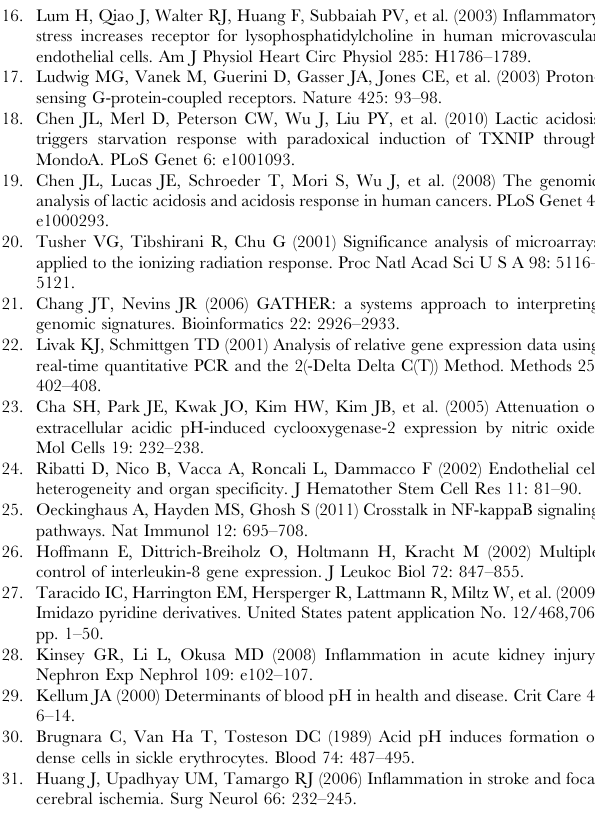
Table S3 SAM analysis of genes that were induced by GPR4 overexpression in HUVECs. (XLSX) Table S4 SAM analysis of genes that were repressed by GPR4 overexpression in HUVECs. (XLSX) Table S5 Table of Gene Ontology enrichment generated by GATHER using the GPR4 overexpression-induced genes from Table S3. (XLSX) Table S6 Table of Gene Ontology enrichment generated by GATHER using the GPR4 overexpression-repressed genes from Table S4. (XLSX) Table S7 Fold changes of gene expression by real-time RT-PCR in HUVEC/Vector and HUVEC/GPR4 cells upon varying pH treatment. (DOC) Video S1 Adhesion of U937 monocytes to HUVEC/ Vector cells that were treated with pH 8.4. Adhesion of U937 monocytes to pH-treated HUVECs under a flow condition was performed as described in the ‘‘Materials and Methods’’. A 15-second video clip of the HUVEC-U937 cell adhesion is presented. (AVI) Video S2 Adhesion of U937 monocytes to HUVEC/ Vector cells that were treated with pH 7.4. (AVI)